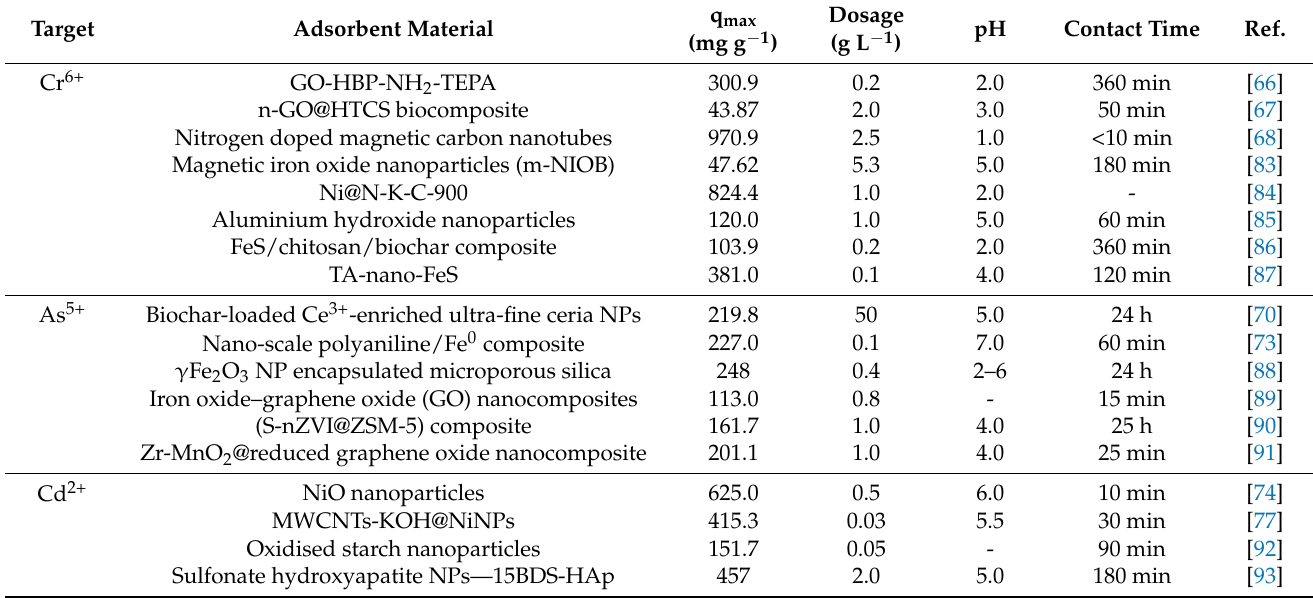
Table 1. Comparison of adsorption capacities of different nanoparticles for different heavy metals.